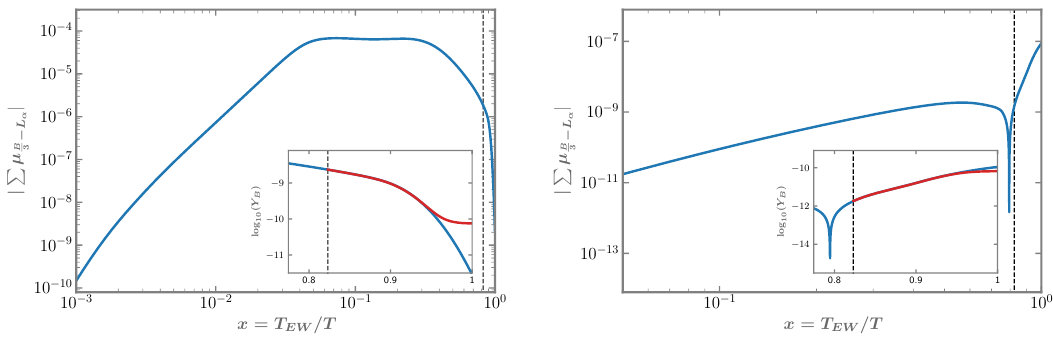
Figure 5 . Comparison of the smooth sphaleron freeze-out (red) to the instantaneous approximation (blue). Deviations can be as large as O (10) if all modes leave the weak coupling regime close to T EW (left) and at most a factor of two if at least one mode remains weakly coupled